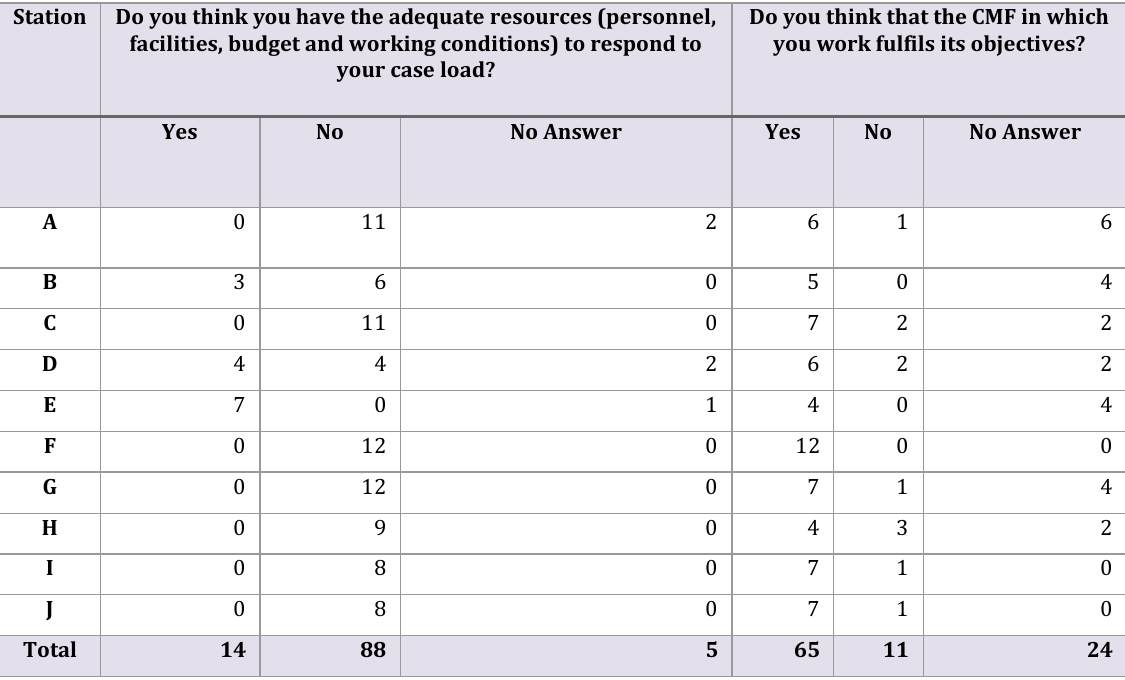
Table 9: Resourcing and functioning of w omen’s police